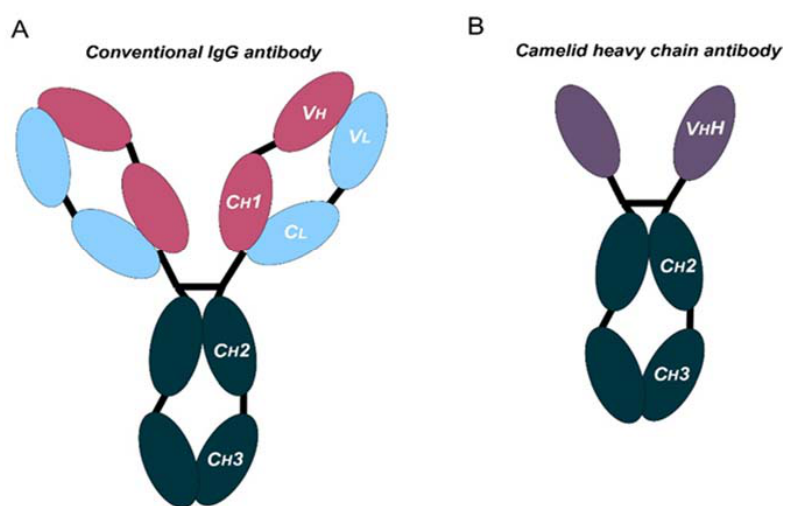
Figure 1. Schematic representation of the structure of conventional and camelid heavy ‐ chain anti ‐ bodies. ( A ) Structure of a conventional IgG antibody, composed by two heavy and two light chains. Conserved and variable heavy ‐ chain domains (Ch, Vh) and light domains (Cl, Vl) are indicated. ( B ) Structure of a camelid heavy ‐ chain antibody, composed by two heavy chains .